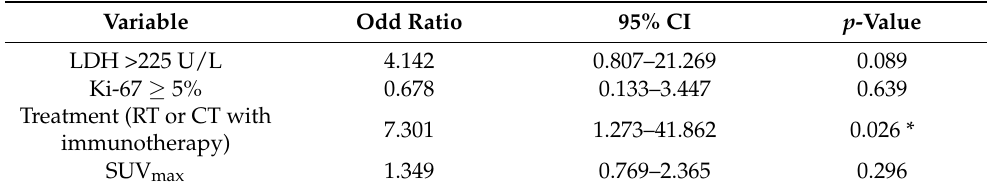
Table 3. Multivariable analysis of clinicopathologic factors regarding the non-complete remission outcome ( n =